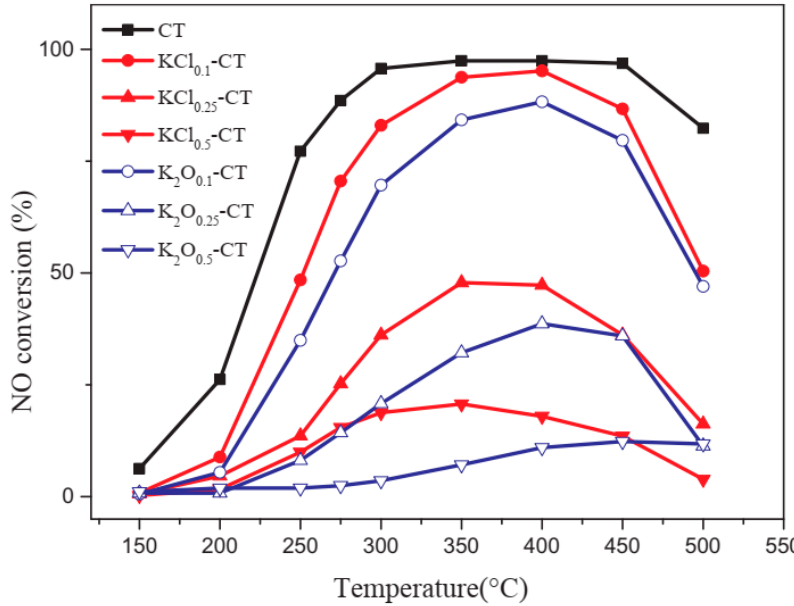
Figure 6. NO conversion of KCl x -CT, K 2 O x -CT and CT. Reaction condition: [NO] = [NH 3 ] = 1000 ppm, [O 2 ] = 3%, N 2 balance, total flow rate = 500 mL/min, GHSV = 90,000 h − 1 [48].